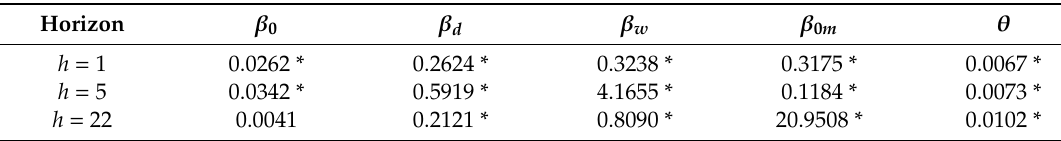
Table 2. In-sample predictability